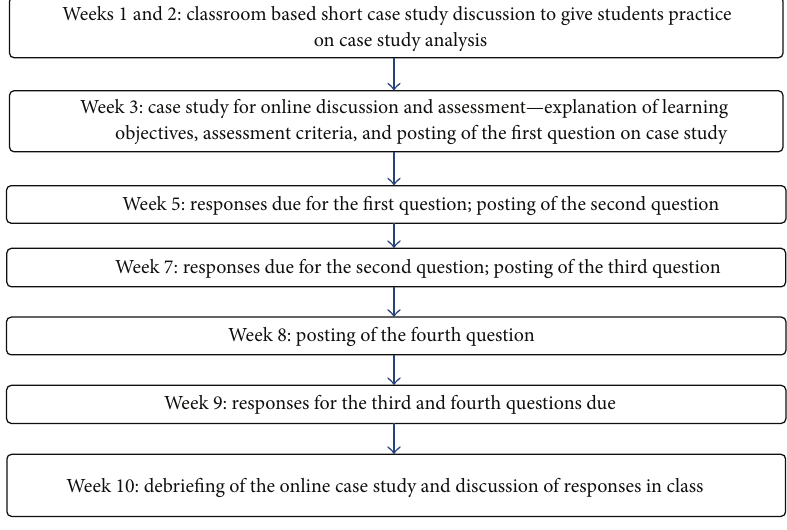
Figure 1: Timeline for the online case study discussion. Table 1: Demographics of